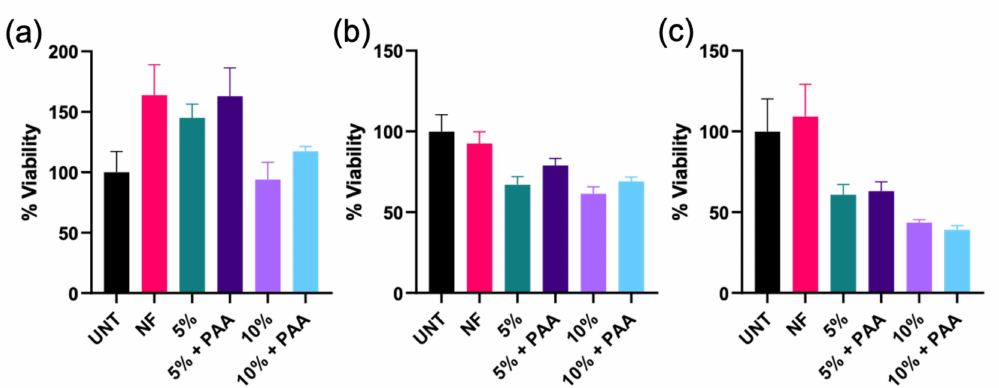
Figure 6. MTS cytotoxicity assays of the electrospun CANFs for 24 h incubation. ( a ) 2 mg/mL, ( b ) 4 mg/mL, and ( c ) 8 mg/mL CANFs. UNT denotes untreated 3T3 adipose cells, NF denotes unmodified CANF, 5% denotes 5 wt.% Ib- loaded CANF, 5% + PAA denotes 5 wt. % Ib-loaded CANF coated with poly-AAm polymer, 10% denotes 10 wt.% Ib-loaded CANF, and 10% + PAA denotes 10 wt. % Ib-loaded CANF coated with poly-AAm polymer. Data reported as mean ± SEM (N =